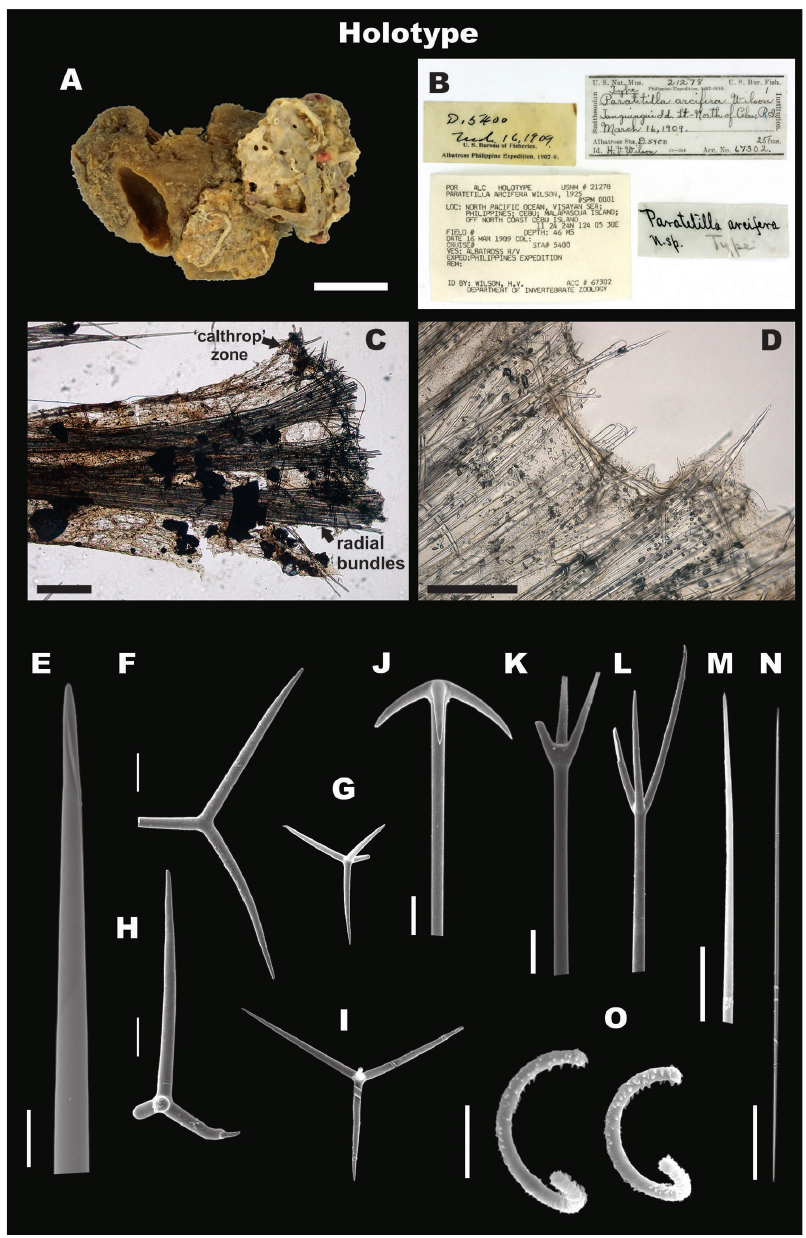
Figure 3. Paratetilla arcifera . Holotype USNM 21278, Malapascua Island, Cebu, Philippines A pre- served specimen showing large porocalices B Labels of holotype C skeleton, showing calthrops and radial bundles D skeleton, showing oxeas, calthrops, and anatriaenes E oxea, end detail F-I different calthrop shapes and sizes J anatriaene K, L protriaene, different types M thin microxea, detail N thin microxea, full length O sigmaspires. Scale bars: 1 cm ( A ); 500 µm ( C, D ); 100 µm ( E ); 50 µm ( F–I, N ); 20 µm ( J ); 40 µm ( K, L ); 5 µm ( M, O